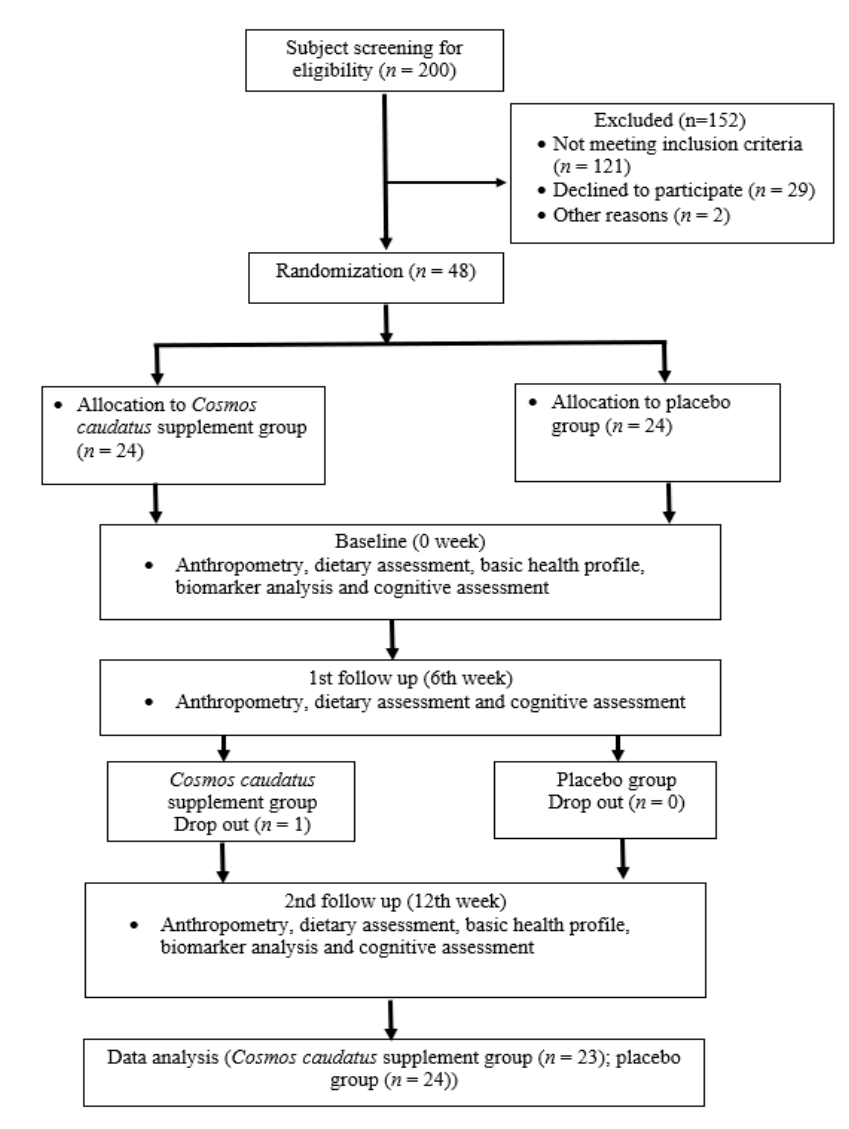
Figure 1. Consort study flow chart.